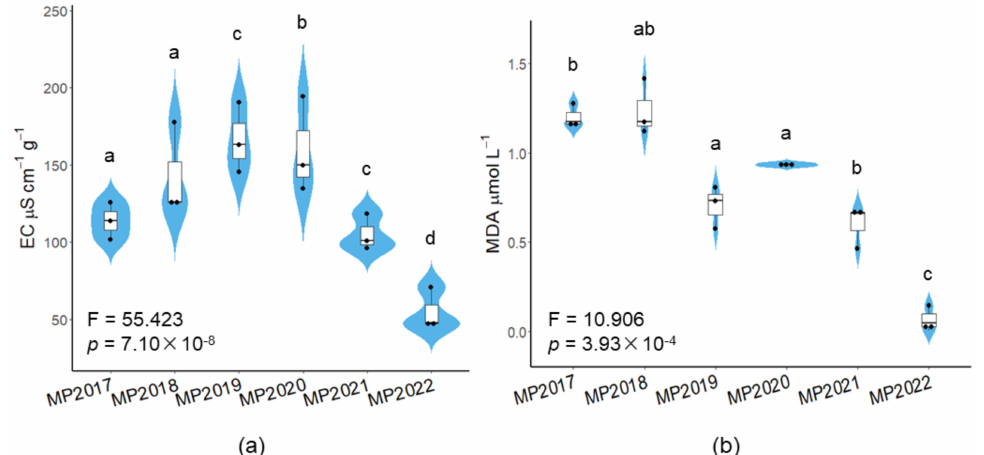
Figure 1. Experiments for the identification of damage at the seed cell level. ( a ) The electrical conductivity, sorted by harvested year; ( b ) the content of MDA, sorted by harvested year. MDA level and seed conductivity both indicate how well the cellular membrane system can be repaired and how much the seed membrane system has been lipid peroxidized. Both show the seeds’ cellular level damage, which in turn shows how viable the seeds are. Storage age did not substantially connect with conductivity at the 0.05 level, according to the Pearson correlation test ( p > 0.278); however, storage age significantly correlated with MDA at the 0.05 level, with an absolute value of 0.896 ( p = 0.016). The results of the analysis of the significance of differences between multiple samples, using Duncan’s multiple range test, are denoted by the lowercase letters a through d, with a denoting the most significant difference and d denoting the least significant difference, at the 0.05 level of